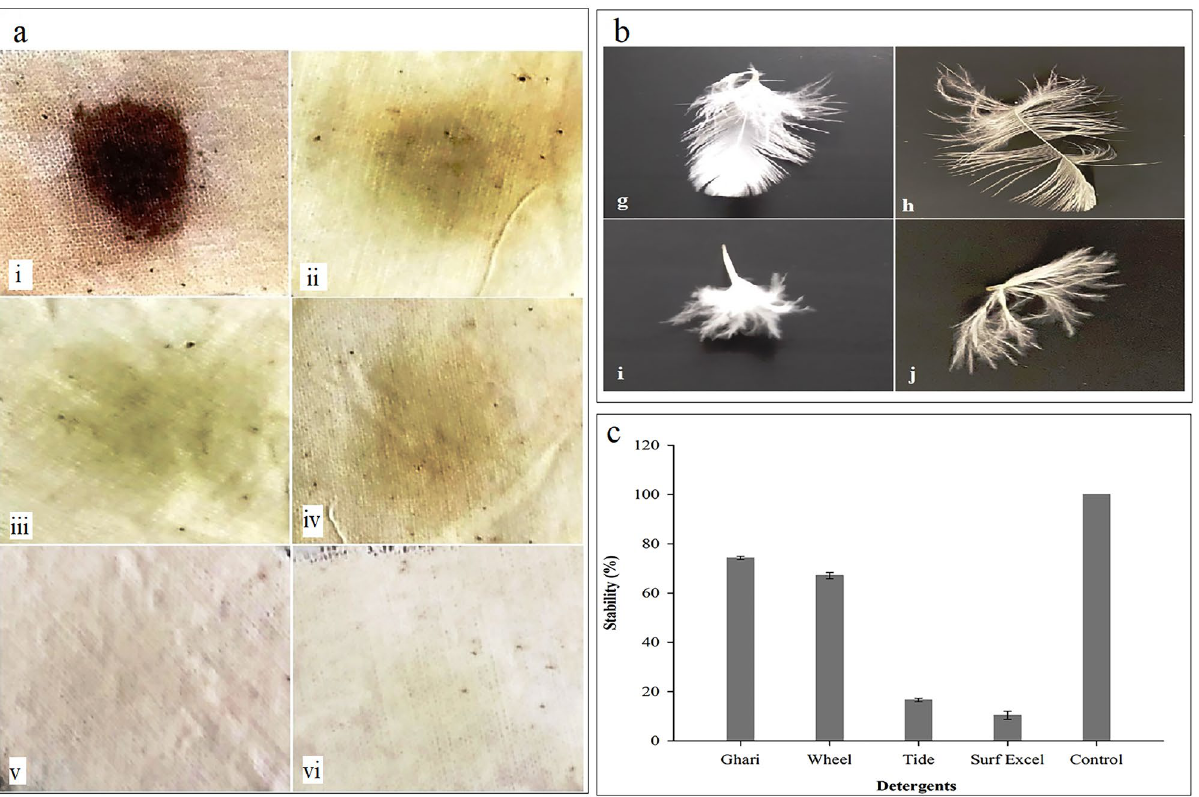
Figure 7. ( a ) Application of purified Apr-BO1 and commercial detergents (Tide and surf Excel) on blood- stained cloth. The treatments given include: (i) untreated cloth, control; (ii) Apr-BO1 only; (iii) Detergent (Tide only); (iv) Detergent (Surf Excel only); (v) Detergent (Tide) + Apr-BO1; (vi) Detergent (Surf Excel) + Apr-BO1. (b) Visual observation of feather fibril detachment when Apr-BO1 enzyme treatment was performed for 8 h at 20 °C. The dehaired feather is shown in the right (h,j), whereas control (without treatment) is shown in the left (g,i). ( c ) Detergent stability of purified